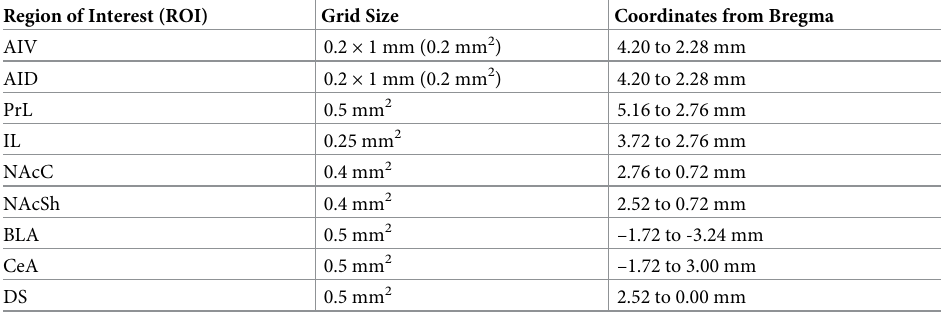
Table 1. Brain region coordinates based on the Paxinos and Watson Atlas